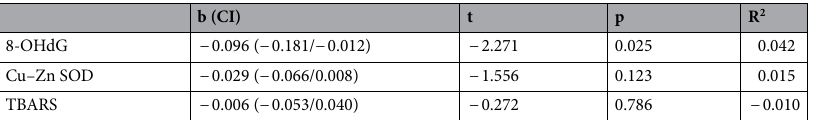
Table 1. A relationship between symmetry scores and measures of oxidative stress tested by regression analyses.